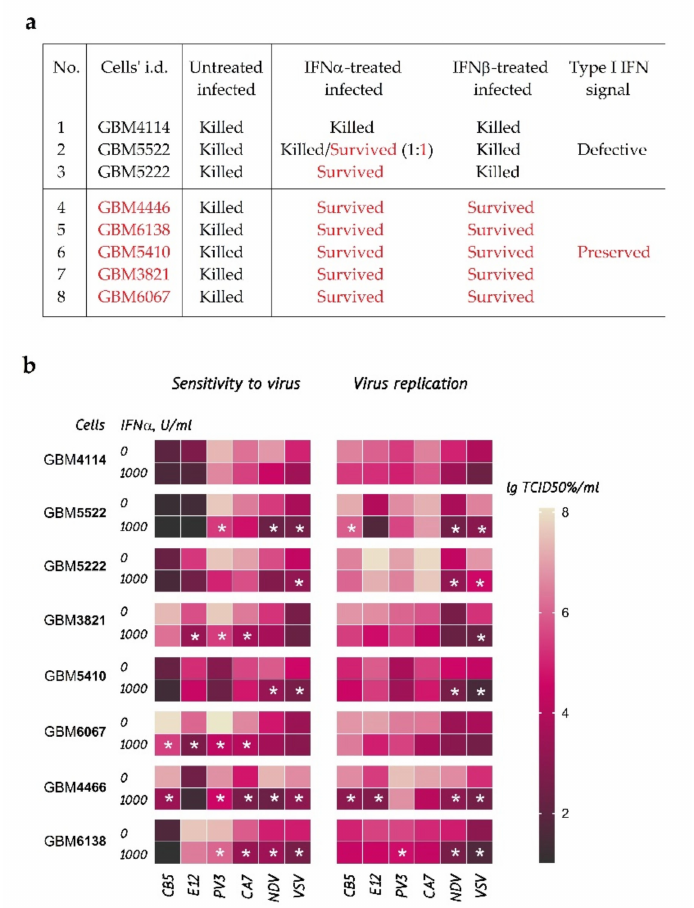
Figure 1. Cytopathic effects (CPEs) in eight GBM cell cultures, pretreated with IFN α or IFN β , and untreated control. ( a ) CPEs of VSV-I by morphology. Test conditions for ( a ): pretreatment with 100 units/mL of IFN α -2b, or 1000 units/mL of IFN β -2b for 24 h, infection with VSV-I at MOI = 1.0. CPEs were observed after 48 h. Culture GBM5522 showed CPE in 2 out of 4 repeats. ( b ) Cell protection against viruses (sensitivity) and virus replication was measured by virus titration. The highest lgTCID50/mL corresponds to the most profound decrease in glioblastoma cells and an increase in the number of virions. Statistically significant changes in sensitivity and replication are calculated using t -test corrected for multiple comparisons with the two-stage linear step-up procedure of Benjamini, Krieger, and Yekutieli (Q-value < 0.01), highlighted by “stars”.